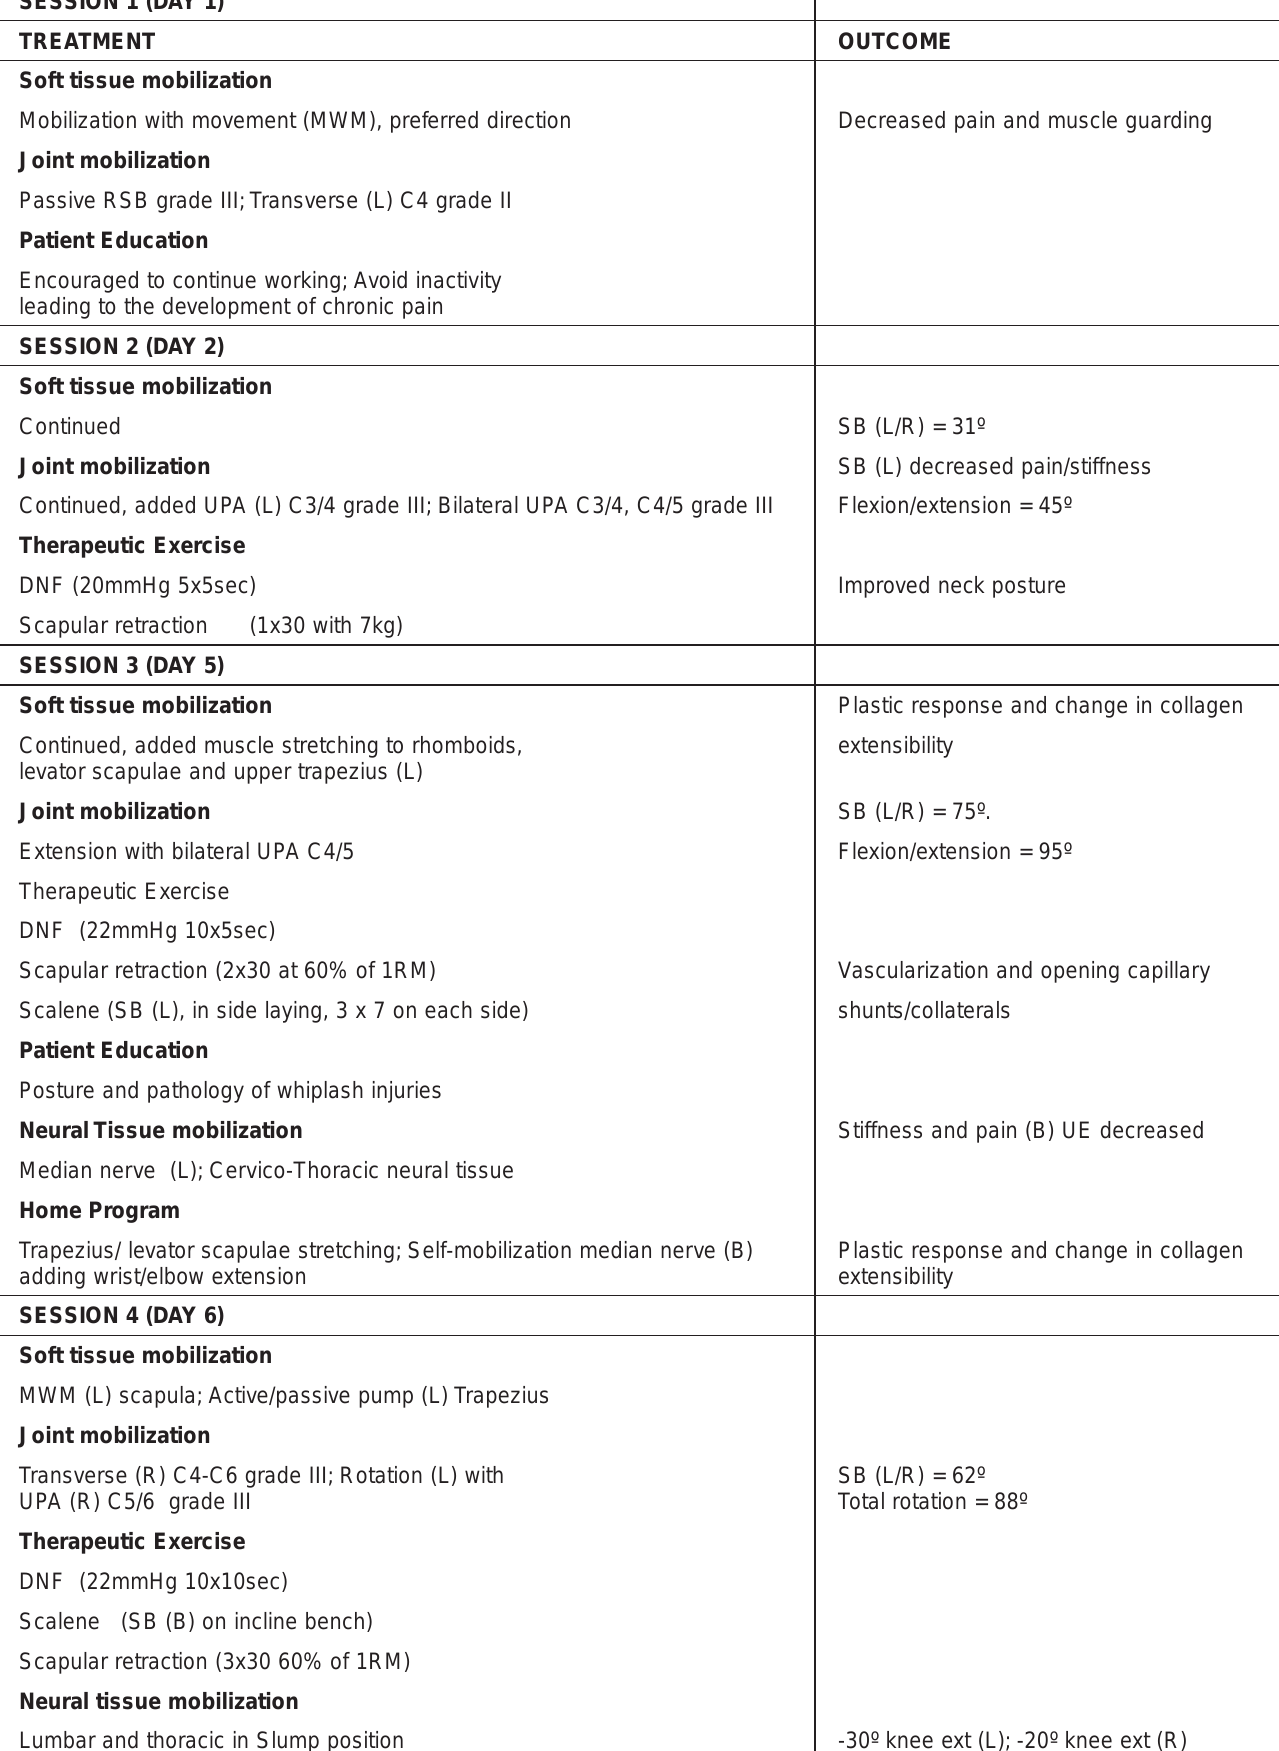
Table 1: Physiotherapy intervention and each sessions’ outcome in session one through six. SESSION 1 (DAY